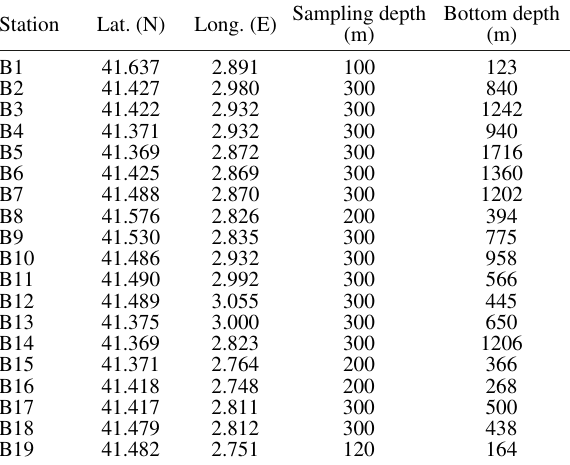
Table 1. – Information on the stations sampled with the Bongo net.